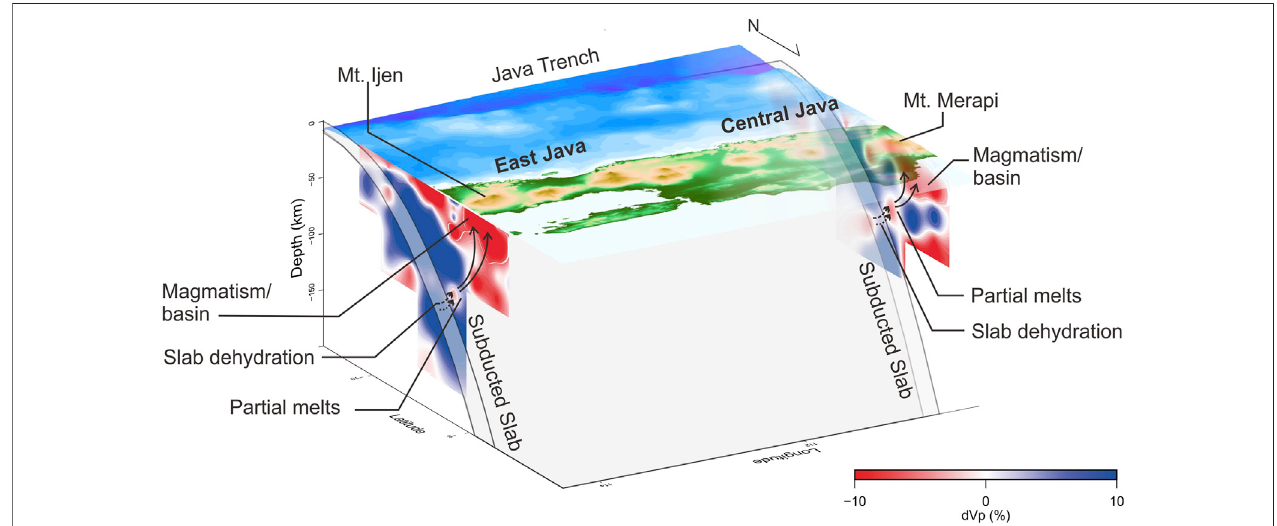
FIGURE 7 | Interpretative cross-sections of the velocity structure from Vp beneath Central and East Java subduction zone. The tomography cross sections show Vp distributions which pass through Mt. Merapi-Merbabu and Mt. Ijen.